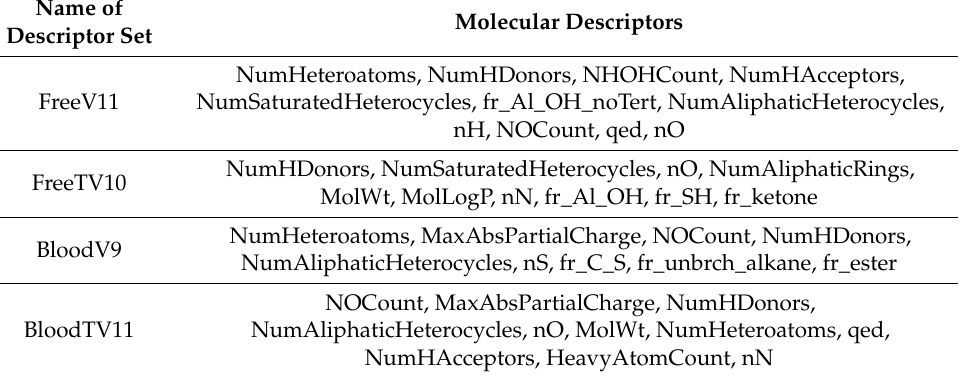
Table 2. Set of molecular